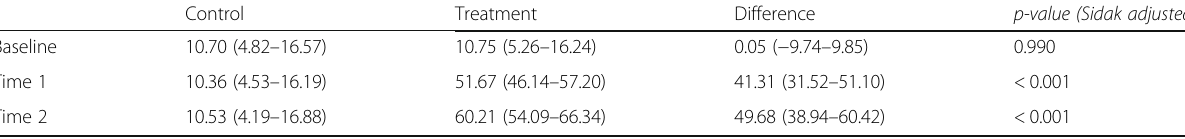
Table 2 Whole Blood Thiamine divided by Hemoglobin (nmol/L/g Hgb) by Time ( n = 117)